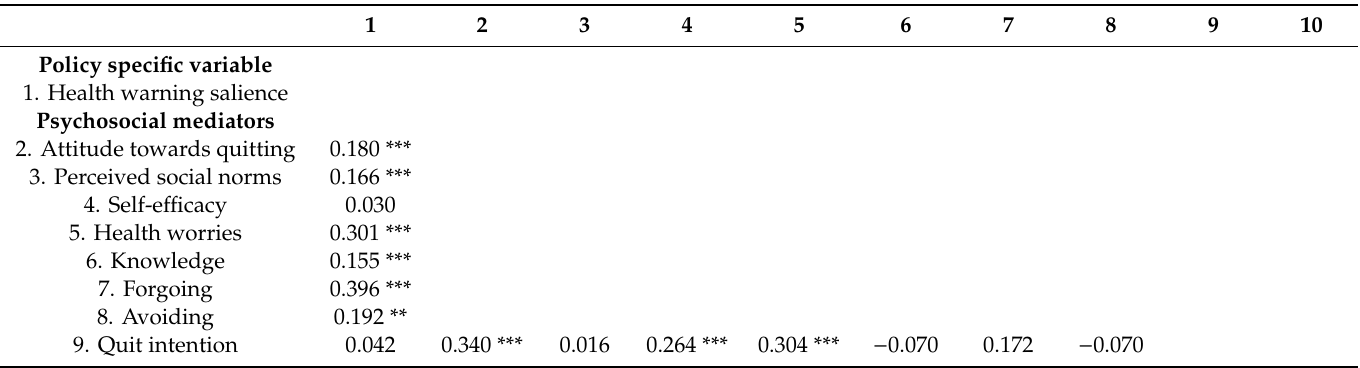
Table 4. Standardized regression coe ffi cients ( β ) of the structural equation model (after multiple imputations), weighted by age and gender a